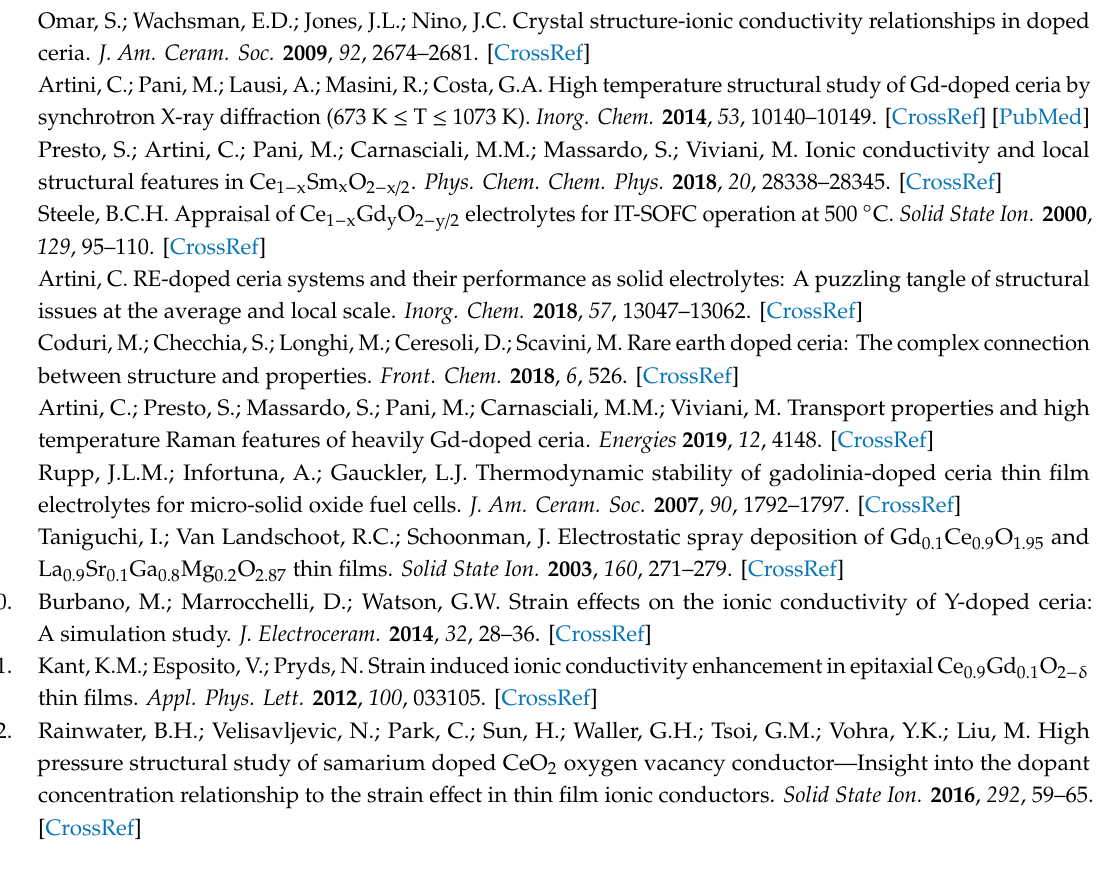
Table S1: Hybrid (H) structural model compared to the F structure typical of CeO 2 and to the C structure typical of sesquioxides of heavy rare